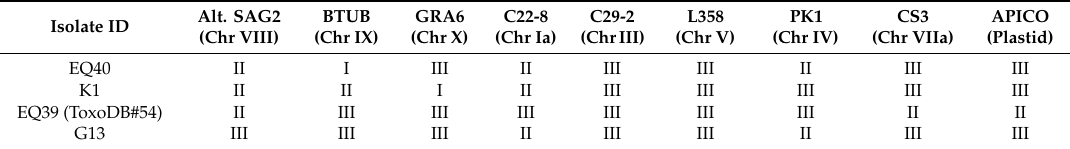
Table 1. MnPCR-RFLP genotypes of the lineage III isolates. EQ39 matches ToxoDB#54, while the other isolates could not be matched in ToxoDB.